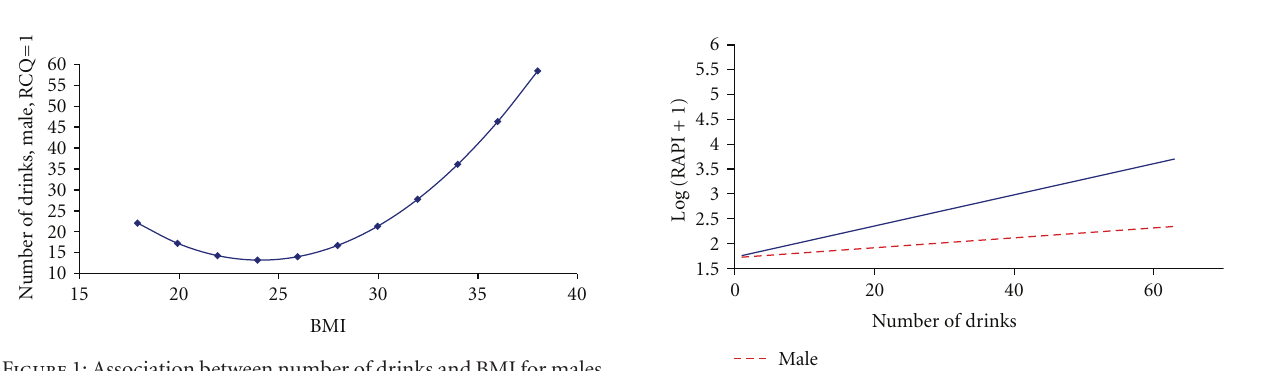
Figure 1: Association between number of drinks and BMI for males in precontemplation stage.